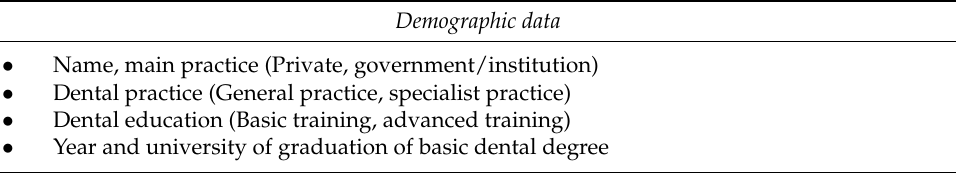
Table 1. Content of the questionnaire.